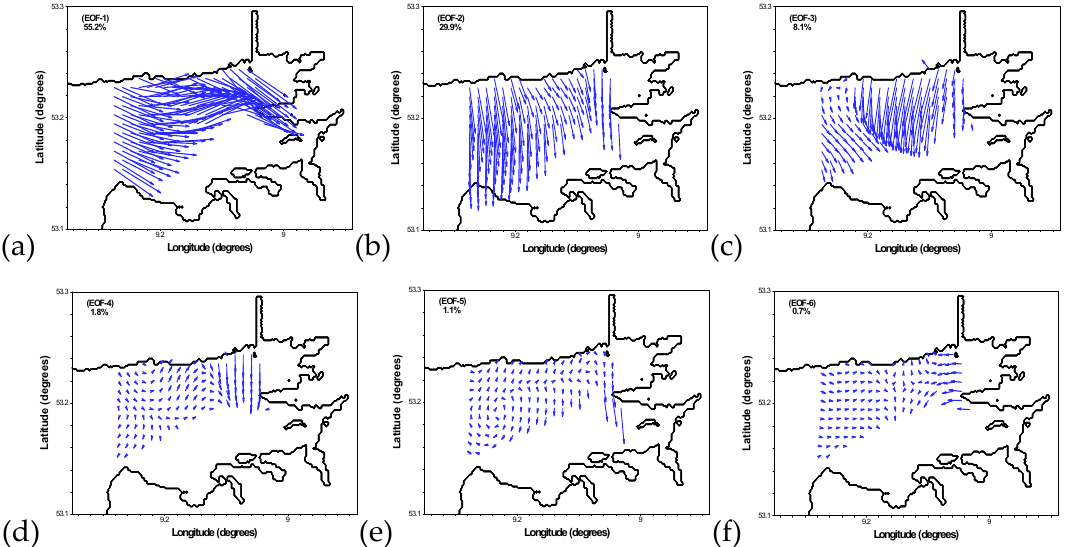
Figure 9. Spatial EOF modes of radar data (subfigures ( a )–( f ) indicates the first to the sixth EOF eigenvector modes, respectively).